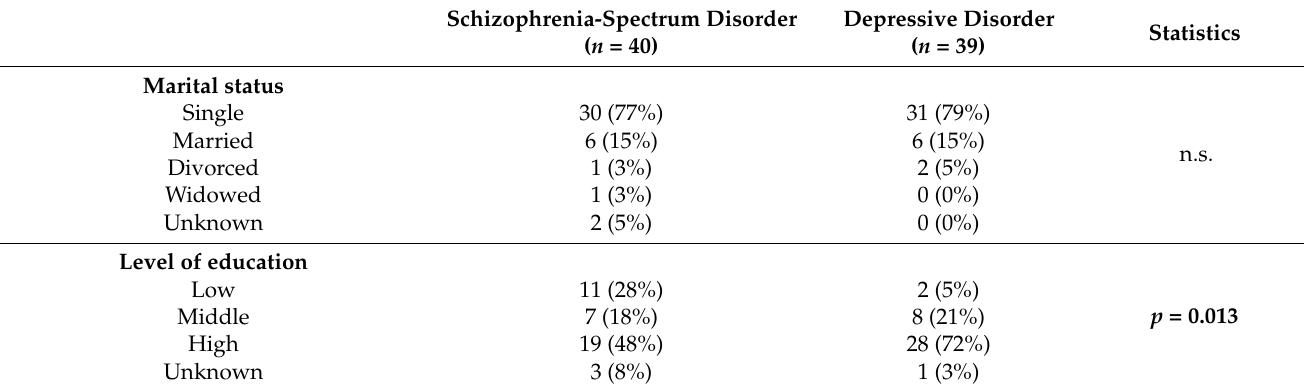
Table 3. Demographic